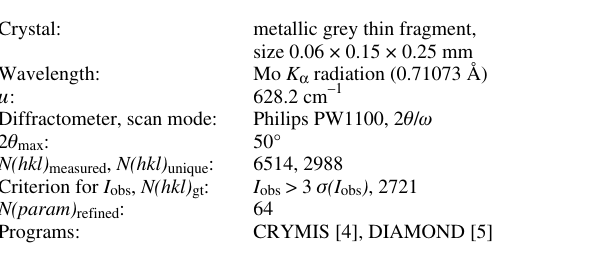
Table 1. Data collection and handling.